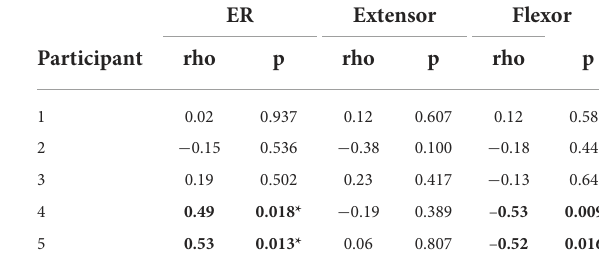
TABLE 4 Changes of muscle activity over time during remote training